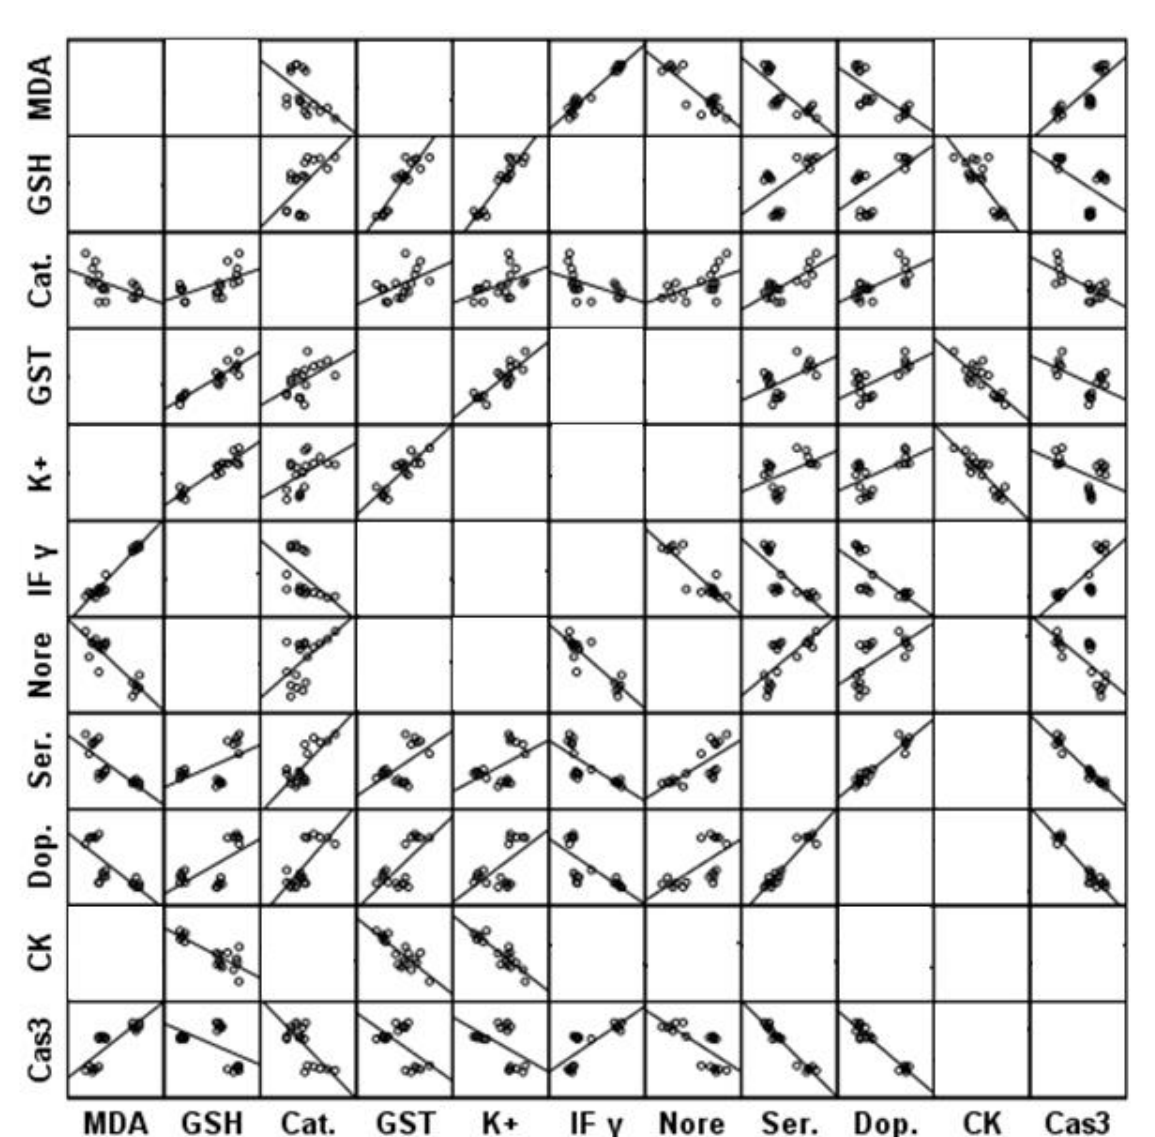
Figure 2. Matrix correlations between all parameters which have significant correlation at 0.05 level. Table 2. Multiple regression using the stepwise method for measured parameters as a dependent variable.